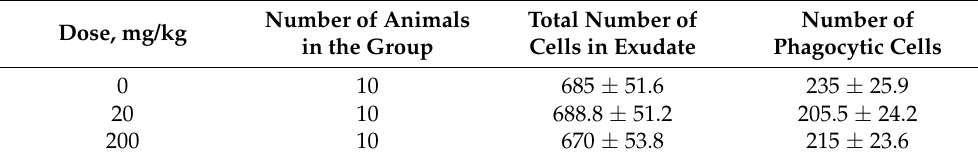
Table 7. Influence of the substance on the phagocytic activity of peritoneal macrophages. Dose,